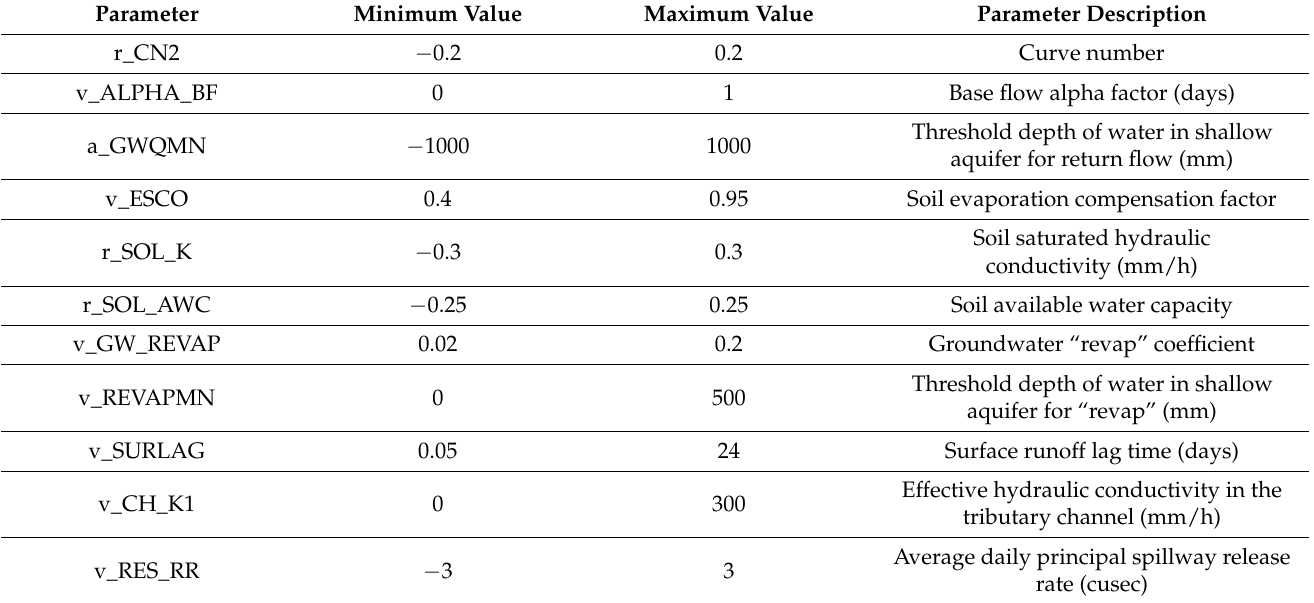
Table 2. SWAT parameters and their initial ranges were used for model calibration and validation at gauges of the Bosque watershed. The model was calibrated for the period